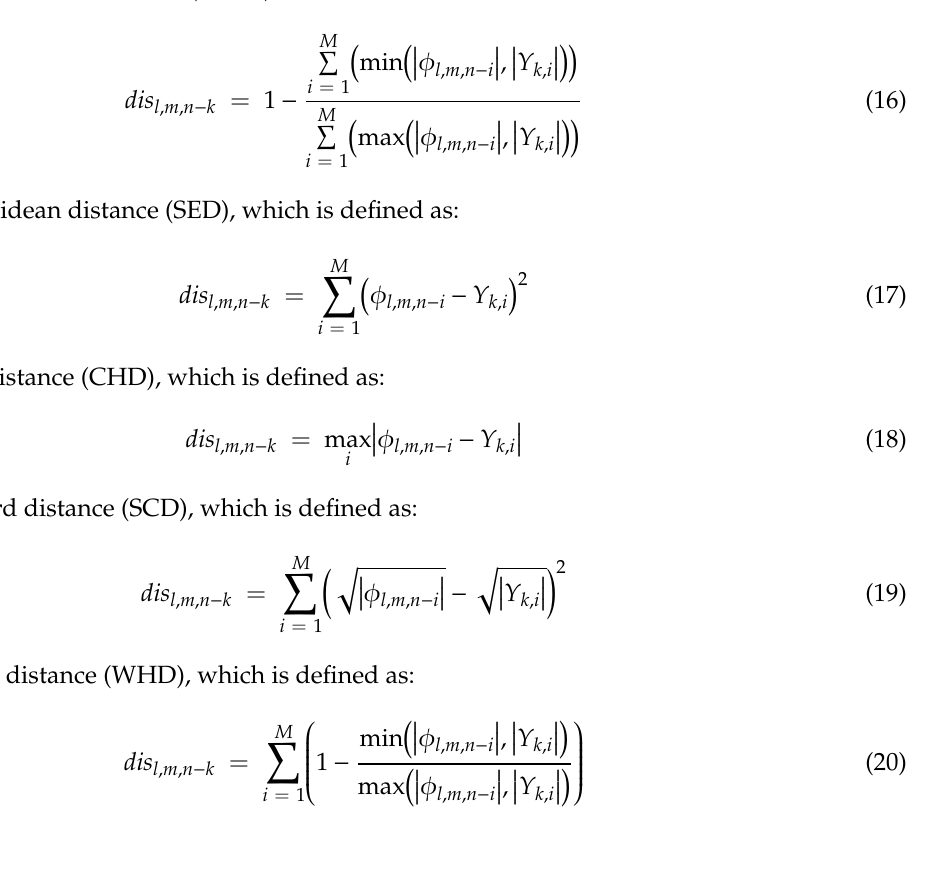
Figure 19. In 3-D, the impact of t on the average positioning error with K max = 8.